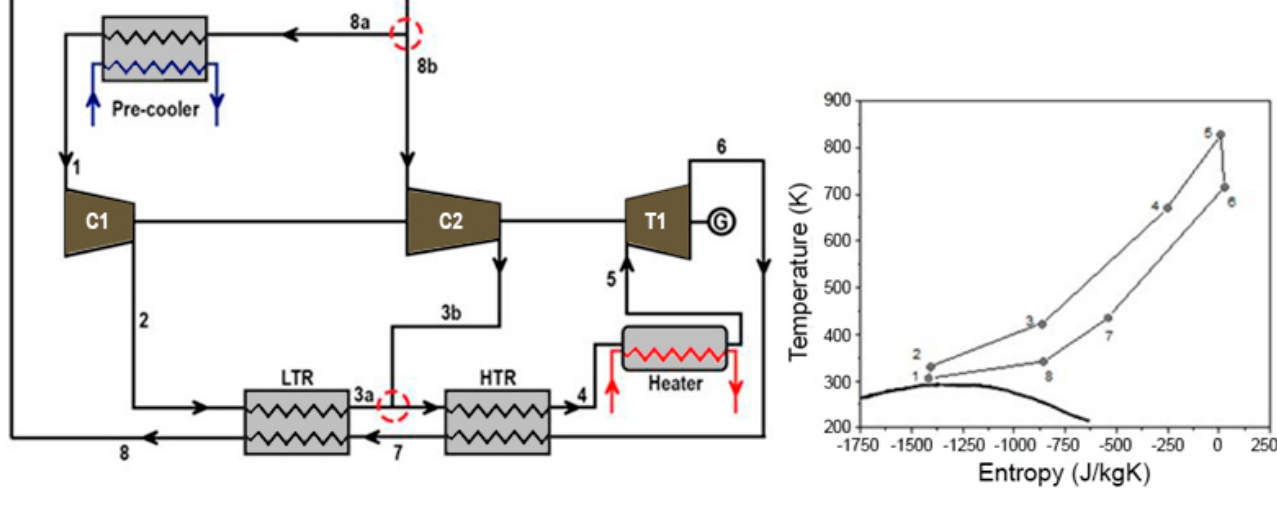
Figure 2. Layout of the recompression s-CO 2 Brayton cycle.